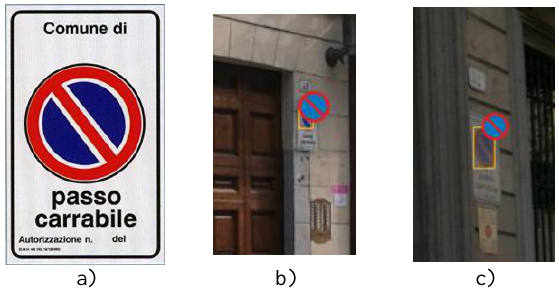
Figure 13. No parking sign in front of private driveways (a) and successful traffic sign recognition by the Mapillary algorithm with unfavourable geometry acquisition settings (b) and (c)